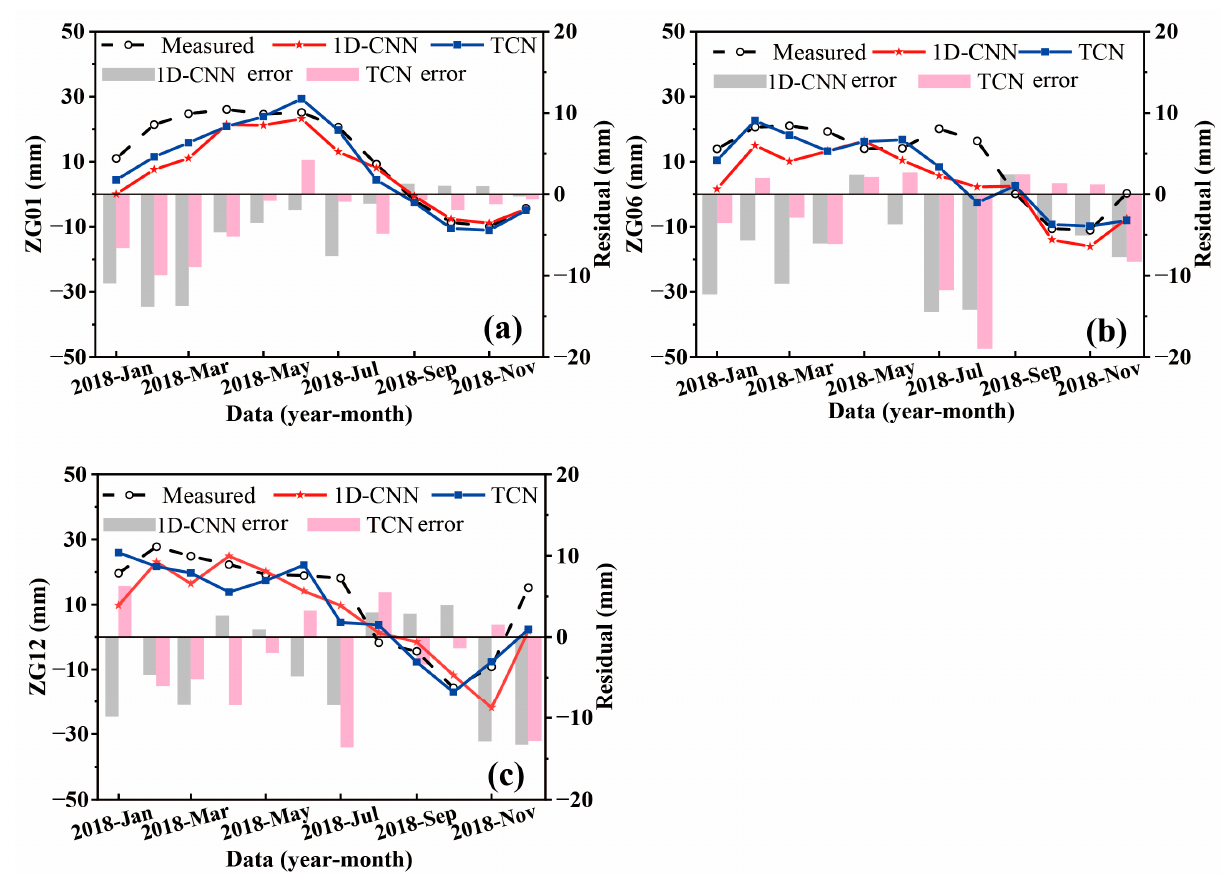
Figure 11. A comparison of monitored and predicted periodic landslide displacements using the 1D-CNN and TCN prediction models for different points: ( a ) ZG01, ( b ) ZG06, and ( c ) ZG12. Table 5. The periodic displacements prediction accuracy among the 1D-CNN and TCN models for the seven